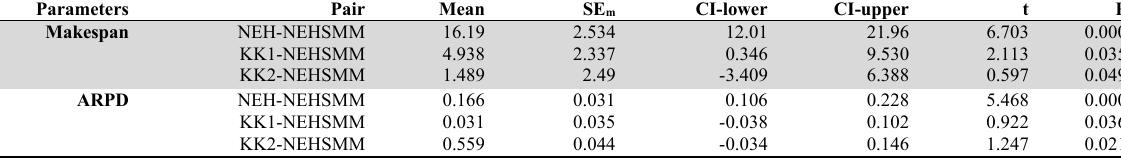
Paired sample t-test for combined VRF and Taillard benchmarks Parameters